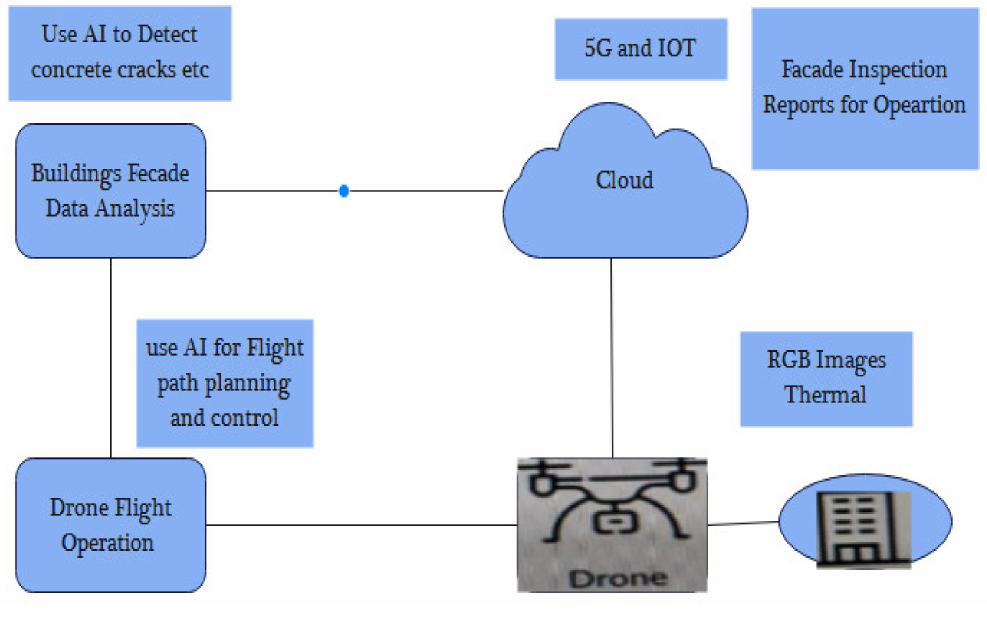
Figure 10. Workflow of a 5G-powered façade inspection system using AI and drones [23].